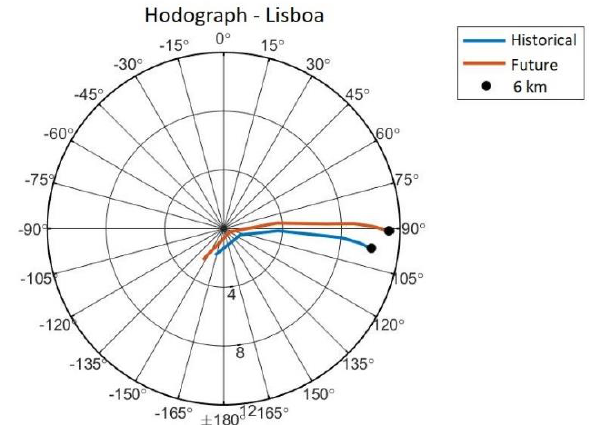
Figure 10. Hodograph for Lisboa, from 0 to 6 km, for historical (blue line) and future (orange line) climates.